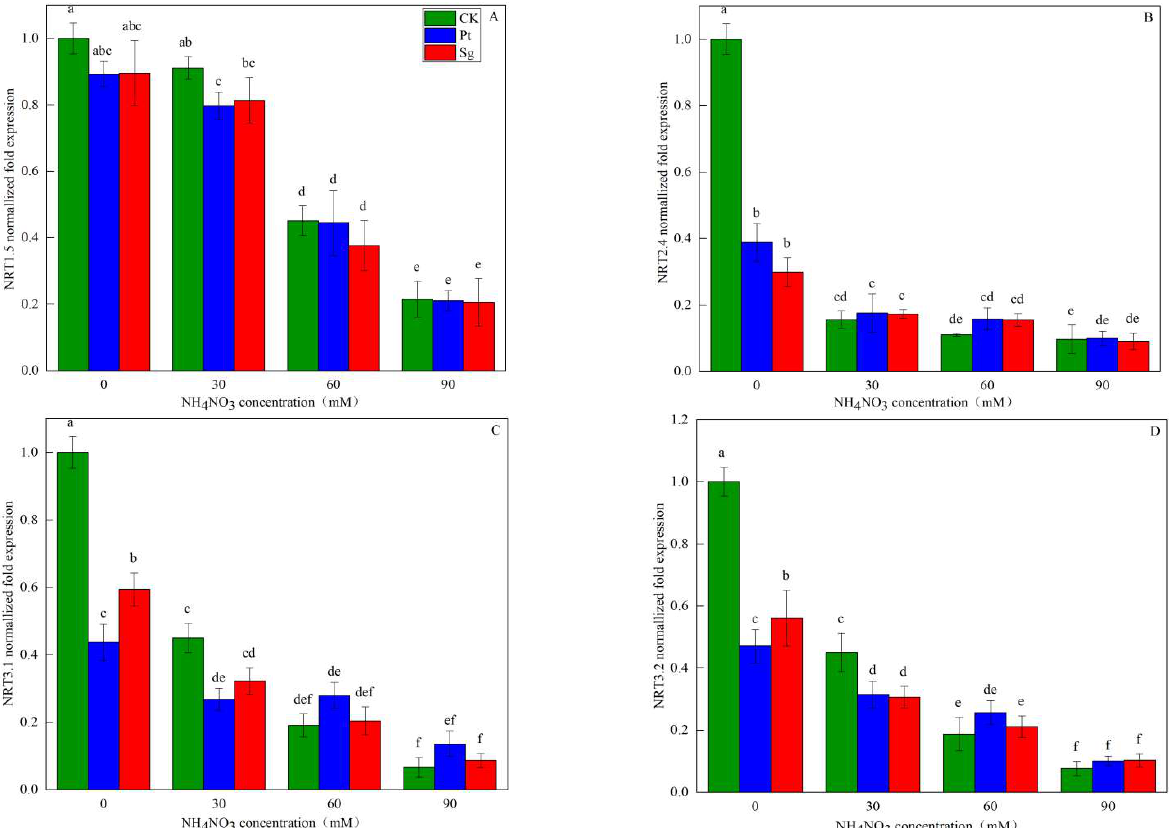
Figure 6. The relative expression of the NRT family genes of Pinus massoniana seedlings as a function of NO 3 − solution concentration (A, B, C and D). Note: Vertical bars illustrate standard errors of means ( n = 3). Differences in treatments were analyzed with the Kruskal-Wallis rank sum test. Significant tests ( p < 0.05) were followed by Duncan’s test of multiple comparisons, significant differences are indicated by lowercase letters.CK: control. Sg: Suillus grevillei . Pt: Pisolithus tinctorius